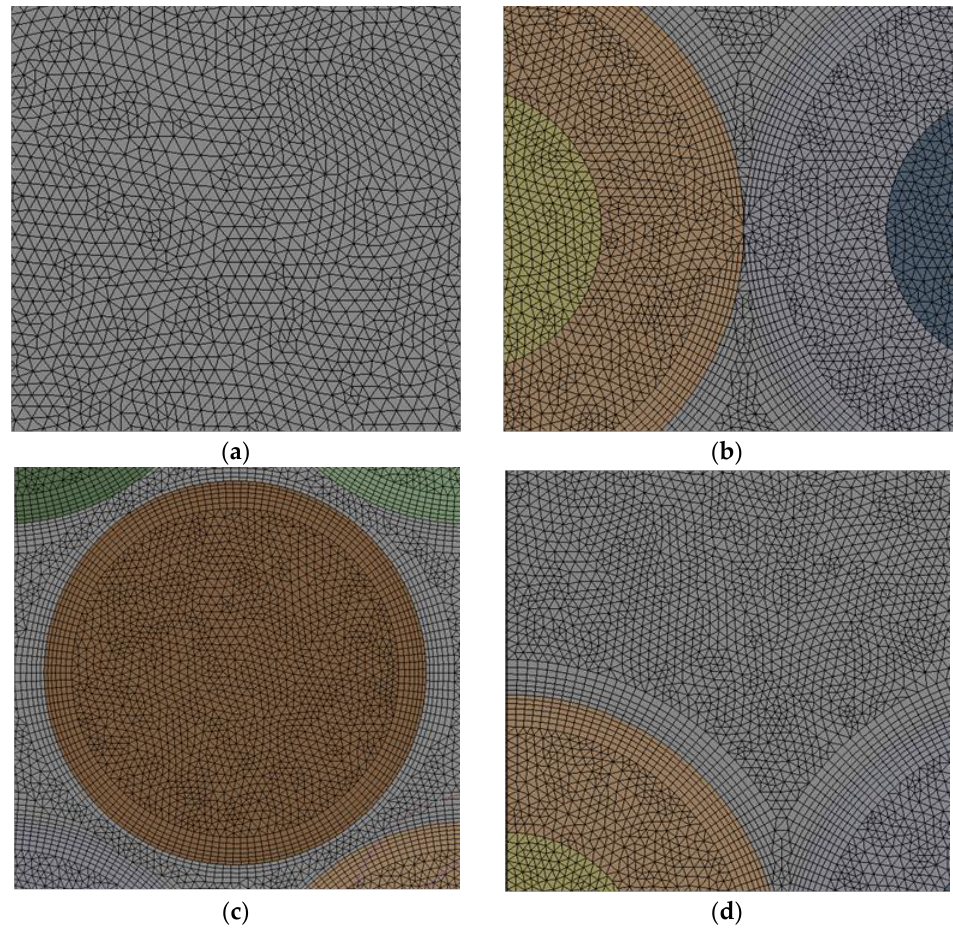
Figure 2. Meshes of ( a ) the fluid, ( b ) the pebble–pebble contact interface, ( c ) the pebbles, and ( d ) the fluid–solid interface.